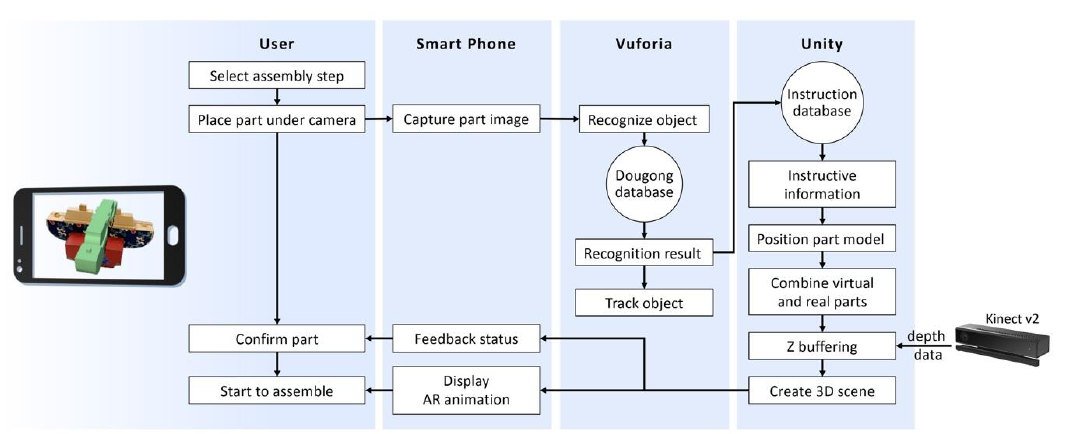
Figure 7. Framework design of AR-based system.